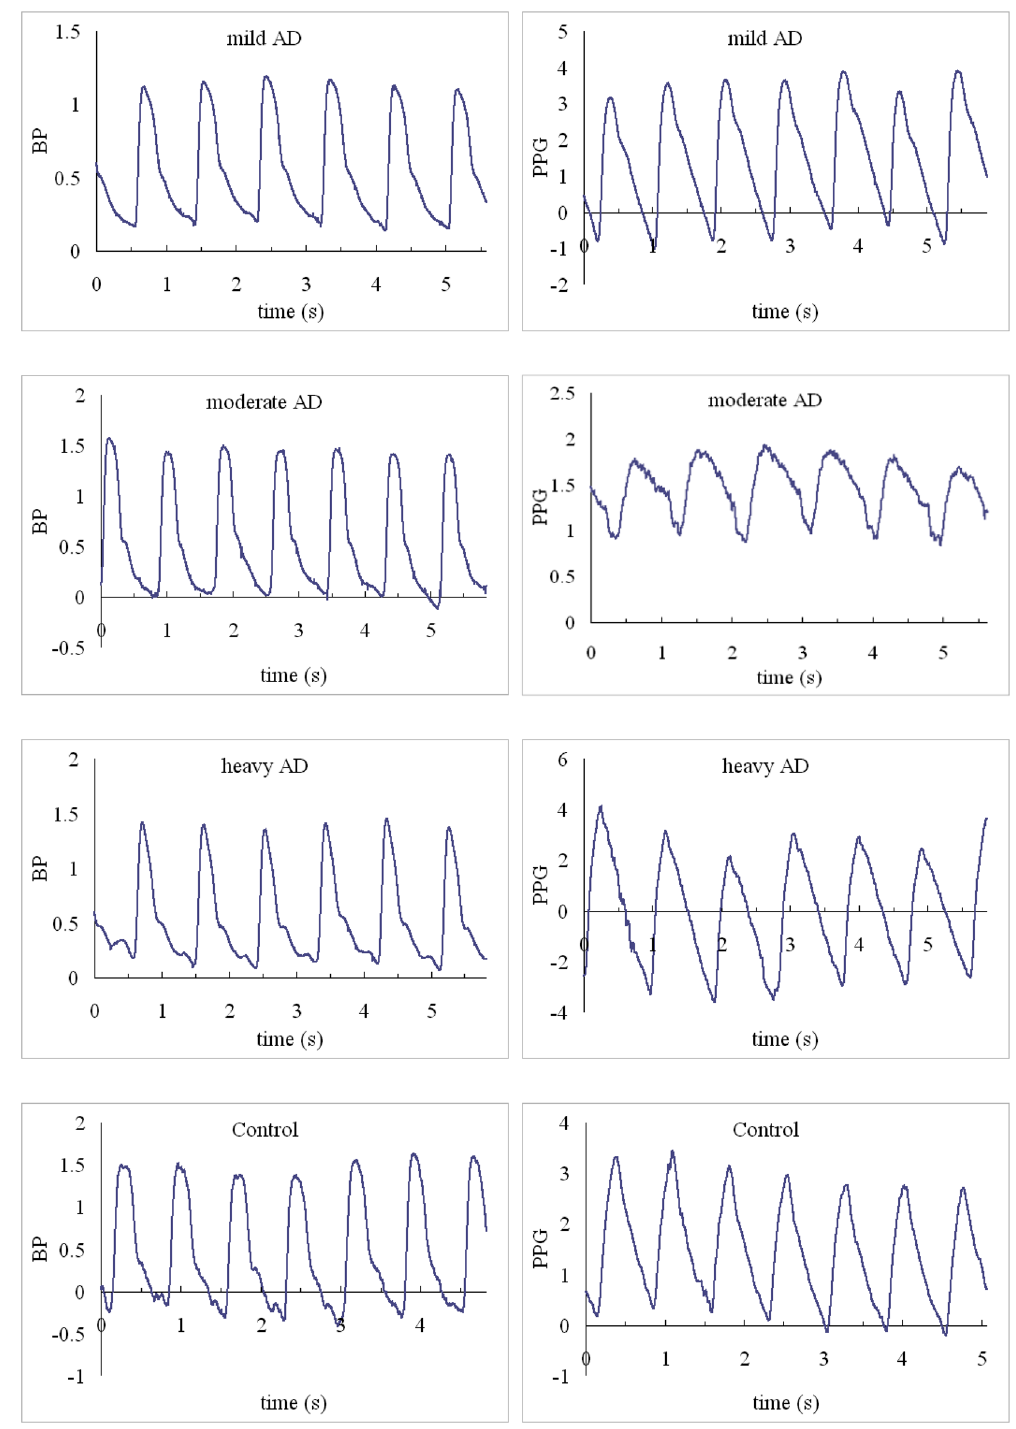
Figure 1. Typical measured pulse